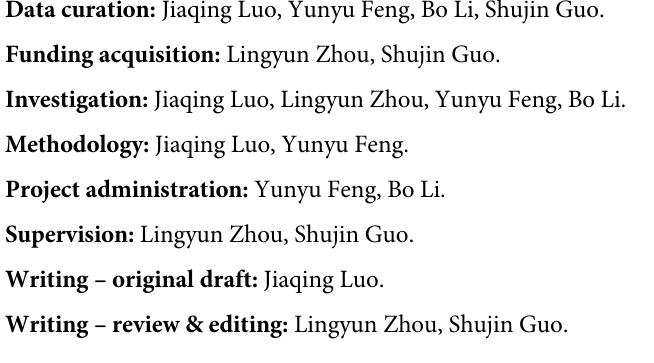
S1 Fig. Clean data detection. After cleaning the data, there is no missing data in the dataset. (TIF) S1 Table. Anonymized data set. For gender, 0 represent female while 1 represent male; For Severity, 0 represent Mild-Moderate while 1 represent Severe-Critically